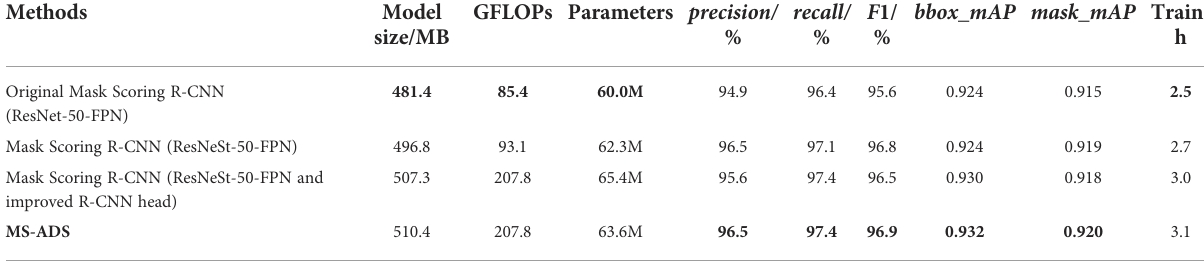
TABLE 6 Detection and instance segmentation results of three